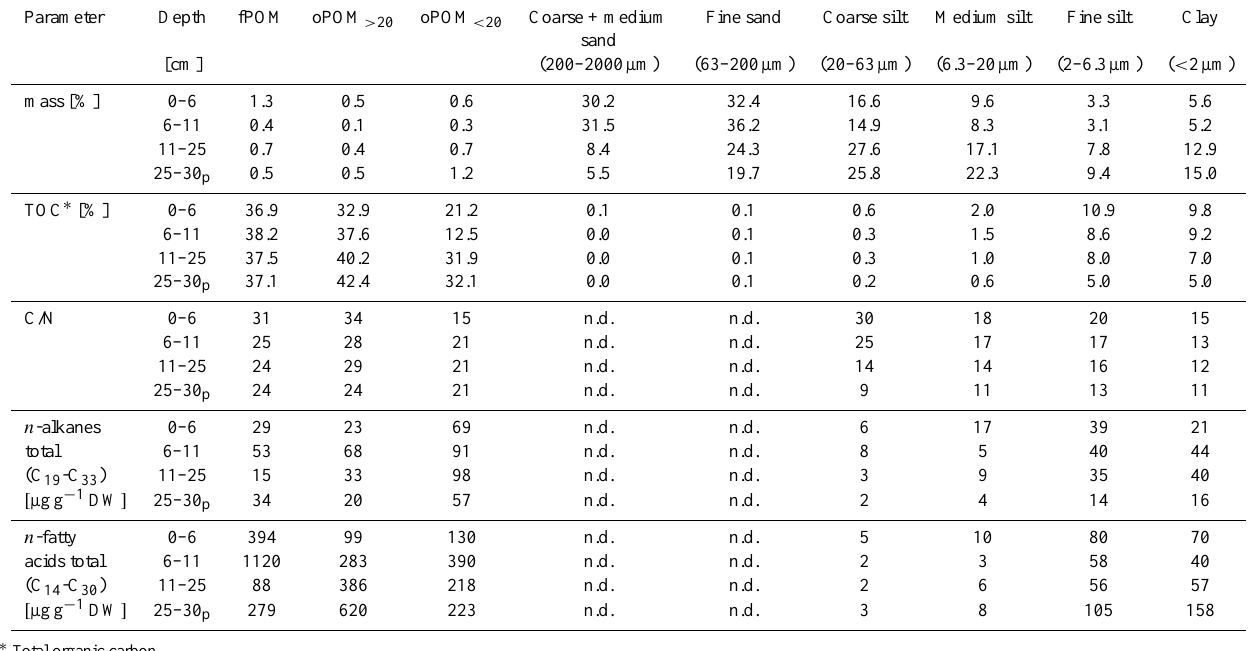
Table 2. Fraction mass and elemental composition of density and particle size soil fractions. Parameter